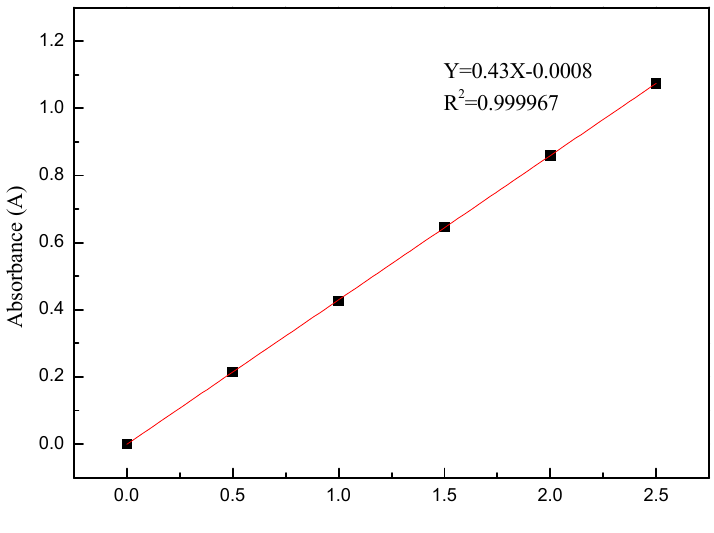
Figure 4. Standard curve of NaOL.